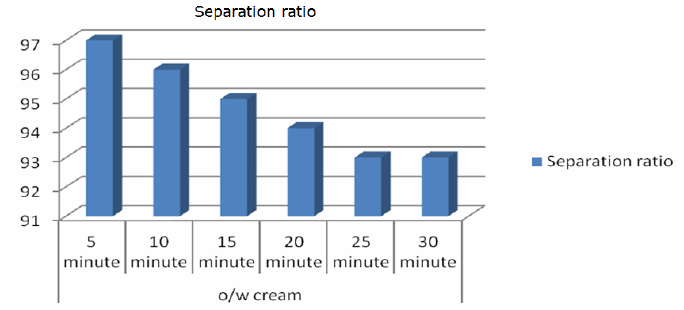
Figure 4: Centrifugation report at speed of 4500 rpm